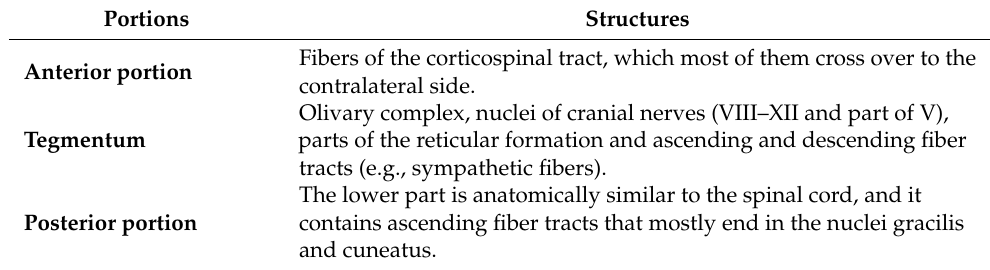
Table 3. Anatomical portions of the medulla oblongata .